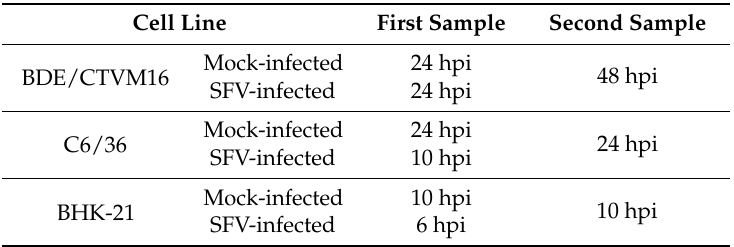
Table 1. Sample time points for each cell line examined by electron microscopy. Each sample represented the entire contents of a single well or tube of cells; hpi = hours post infection with Semliki Forest virus (SFV) or mock